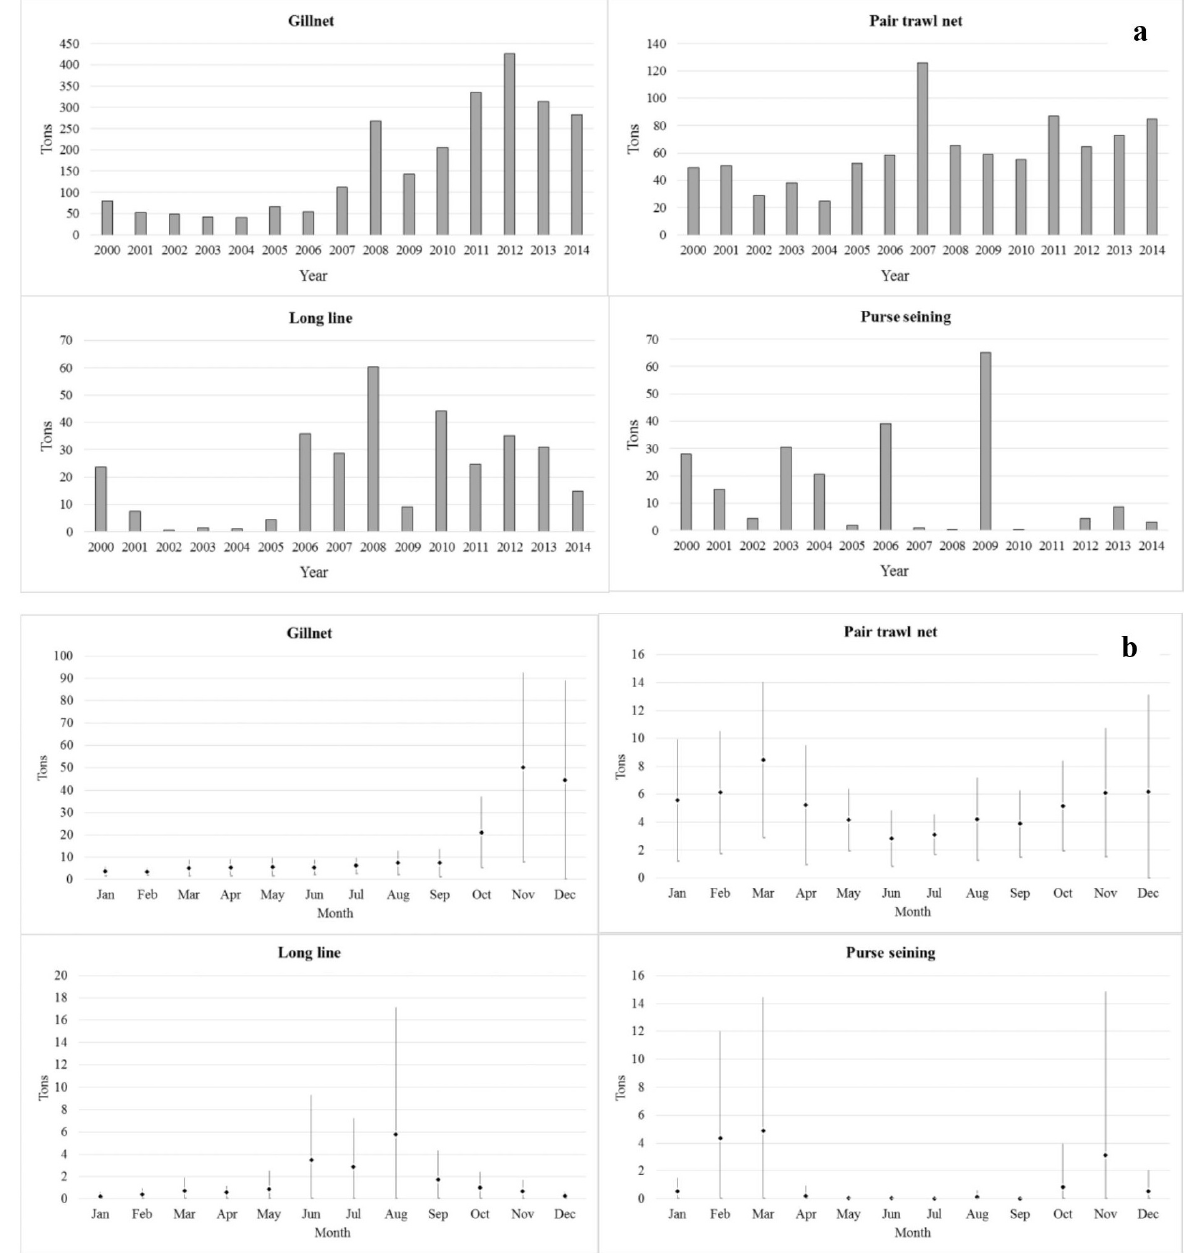
Figure 5. Annual (a) and average months (b) production of marine catfish ( Genidens barbus ) from the main gear fishing of this fishery from 2000 to 2014 on the coast of São